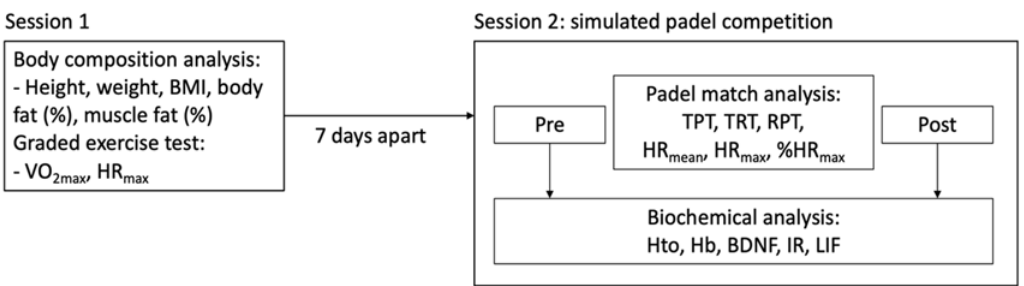
Figure 1. Study Figure 1. Study protocol.